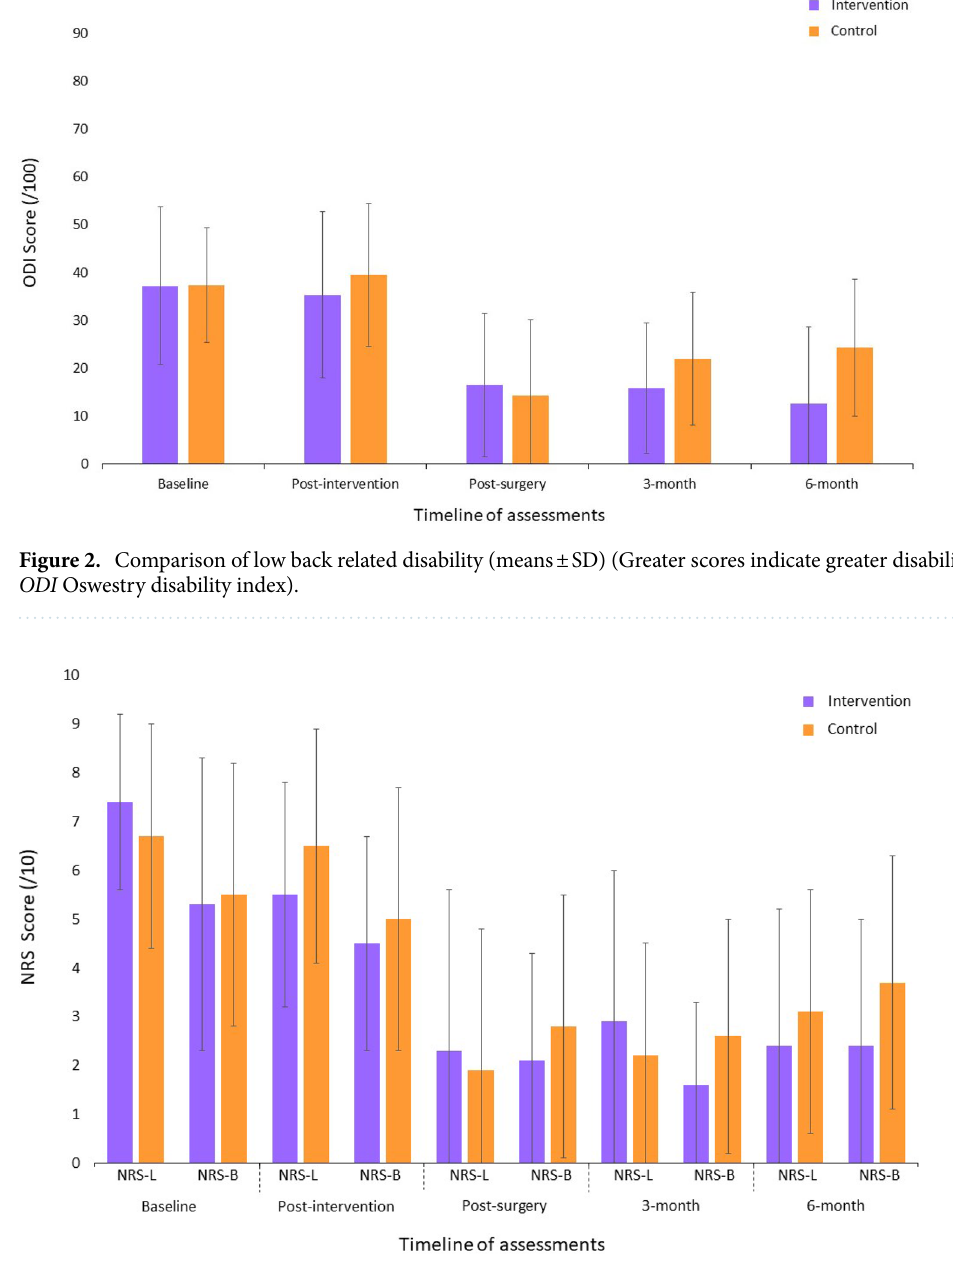
Figure 3. Comparison of leg and back pain intensity (means ± SD) (Greater scores indicate greater pain intensity; NRS-L numerical rating scale for leg pain intensity, NRS-B numerical rating scale for low back pain